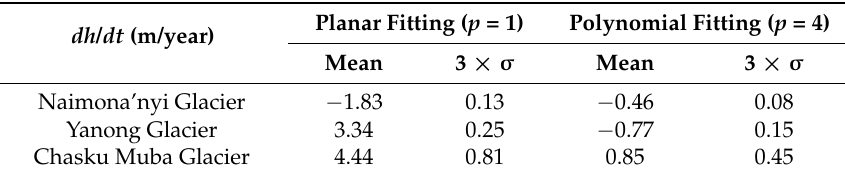
Table 6. Statistics of the glacier thickness change estimation from the 50 duplications of randomly selecting 70% GLAS data for